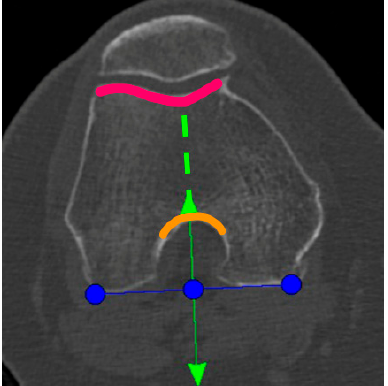
Figure 1. Blue line: tibial rotation landmark co-aligned to the posterior femoral condylar line. Green line: perpendicular to the blue line and centered to the middle of the notch (anterior green arrow and orange curved line) and the trochlea groove (green dotted line and pink curved line).